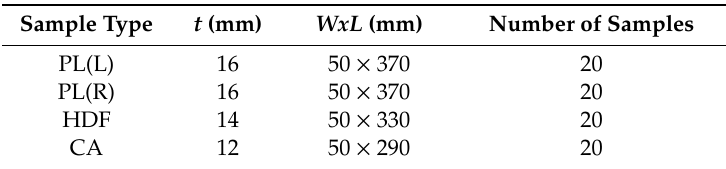
Figure 5. Cross-sections of the beam sample: ( a ) PL, ( b ) HDF, ( c ) CA, t f , t c , t —thickness of facing, core and board, W , L —width and length of the sample. Table 2. Dimensions of samples.